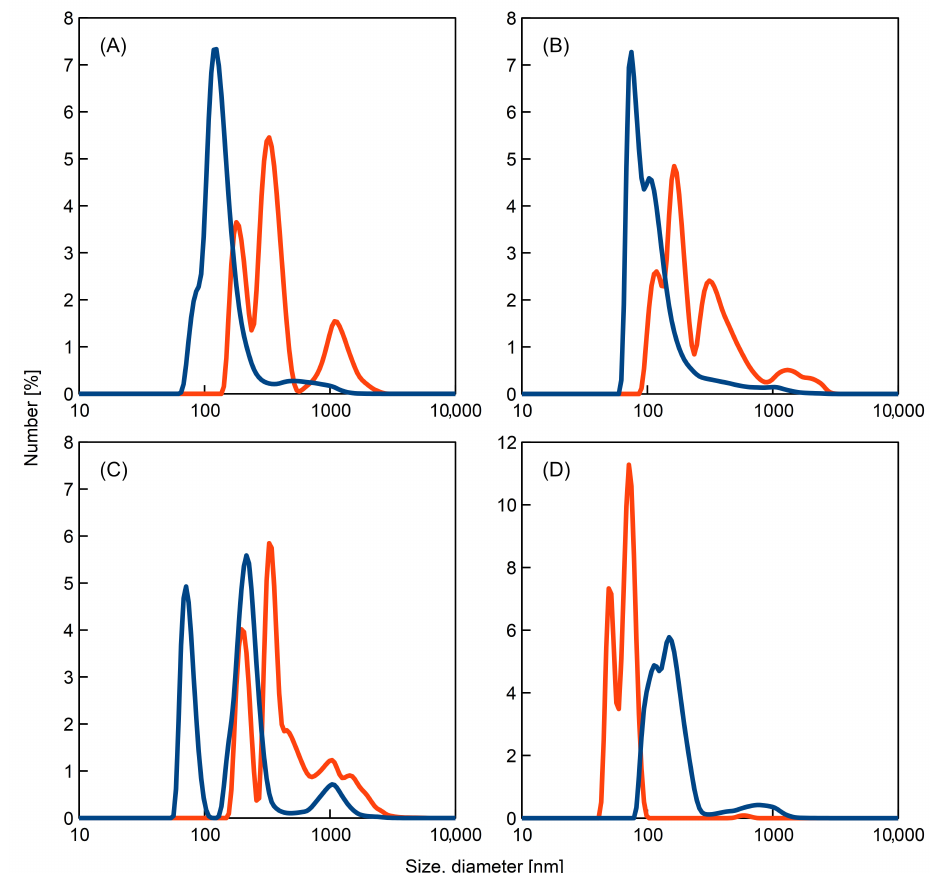
Figure 3. Size distribution by number obtained from dynamic light scattering measurements for the samples of K-peptide in freshly prepared solutions (dark blue line) and for the samples of K-peptide incubated at 37 ◦ C for 14 days (red line) dissolved in: ( A ) water; ( B ) acetate buffer, pH = 4, without additives; ( C ) acetate buffer with dimethyl sulfoxide and ( D ) acetate buffer with